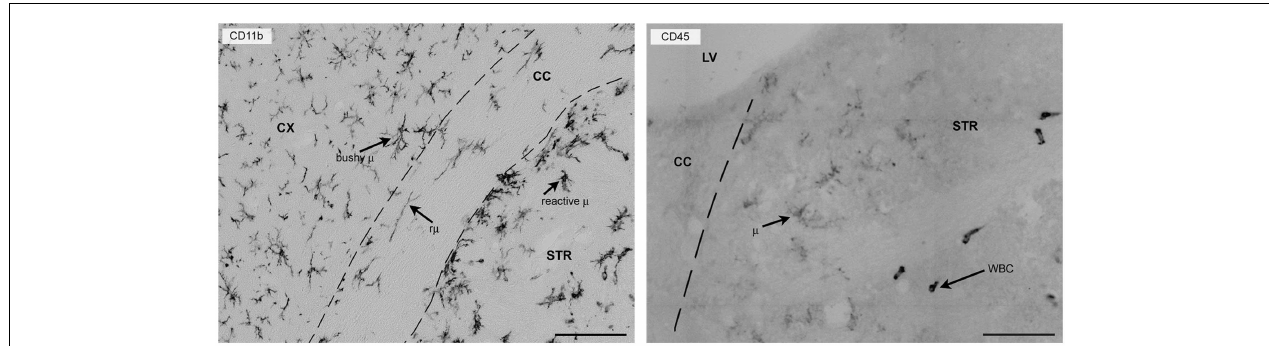
that corresponds to the lesion core. Right panel: CD45 labeling helps distinguish resident microglia from recruited leukocytes. Microglia have ramified morphology and pale staining (CD45 low ), whereas infiltrated leukocytes (white blood cells,WBC) can be identified by their round-shaped morphology and strong, well-contrasted staining (CD45 high ).The elongated shape of CD45 high cells may depend on crawling along vessel walls or their perivascular location. Bars = 100 µ m, microphotograms modified from Ref. (40). Neuro-anatomical structures are indicated by CX (cortex), STR (striatum), CC (corpus callosum), and LV (lateral